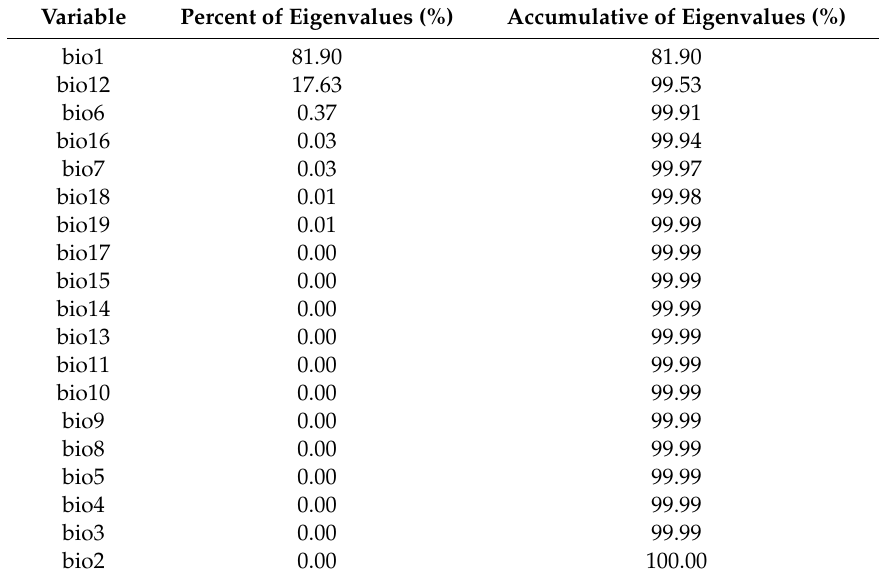
Table A2. Eigenvalues of 19 bioclimatic variables in principle component analysis.